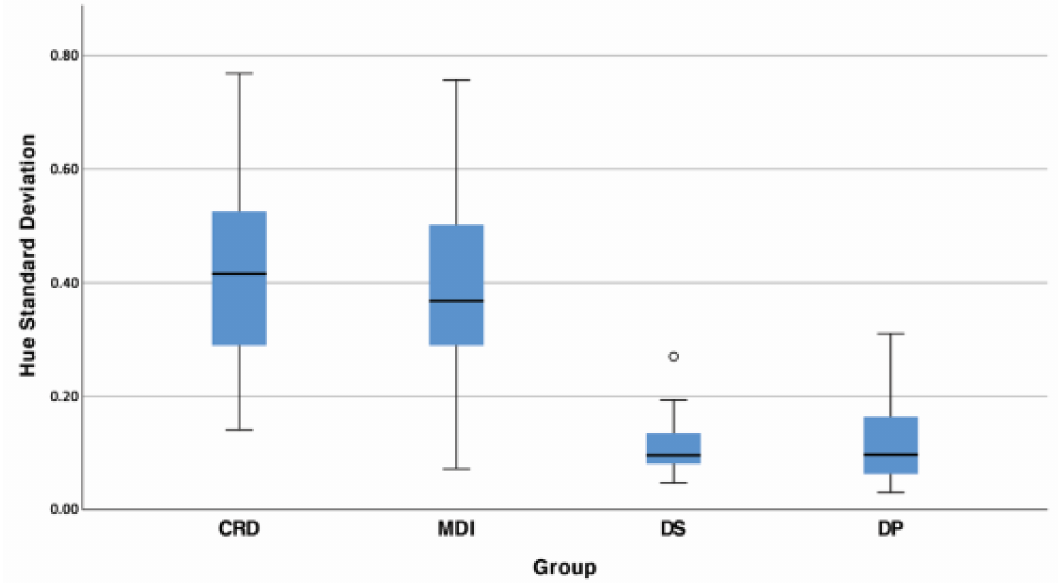
Figure 3. Boxplot of the mean VOH in 4 different groups: (CRD) complete removable denture maxilla/dentate mandible; (MDI) mini dental implant overdenture maxilla/dentate mandible; (DS) dental students; (DP) dentate